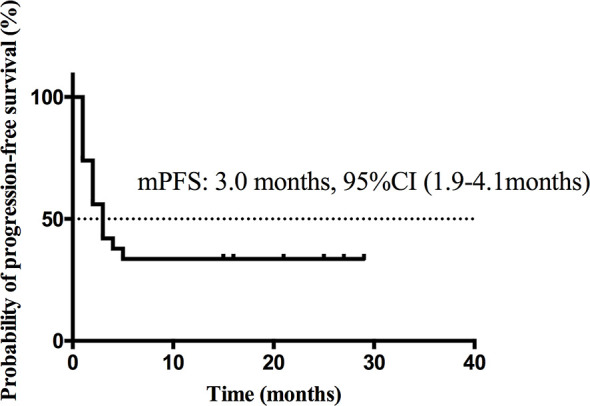
Kaplan-Meier curve of PFS of all patients.